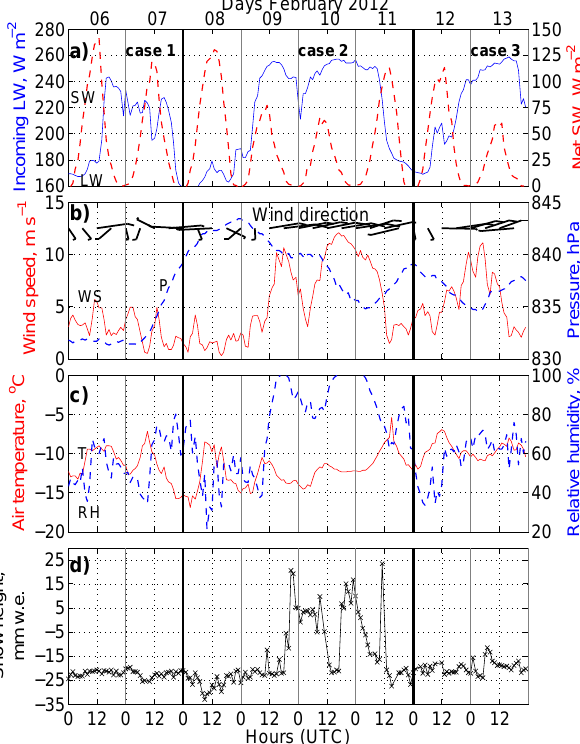
Figure 3. Cloud and precipitation properties derived from ground- based remote-sensing instruments during the case studies period 6–13 February 2012: (a) ceilometer attenuated backscatter pro- files, (b) MRR radar effective reflectivity profiles, (c) MRR mean Doppler velocity profiles, and (d) infrared pyrometer temperature. Horizontal blue lines depict the MRR profile limits from 400 to 3100ma.g.l. Vertical black lines delimit cases.